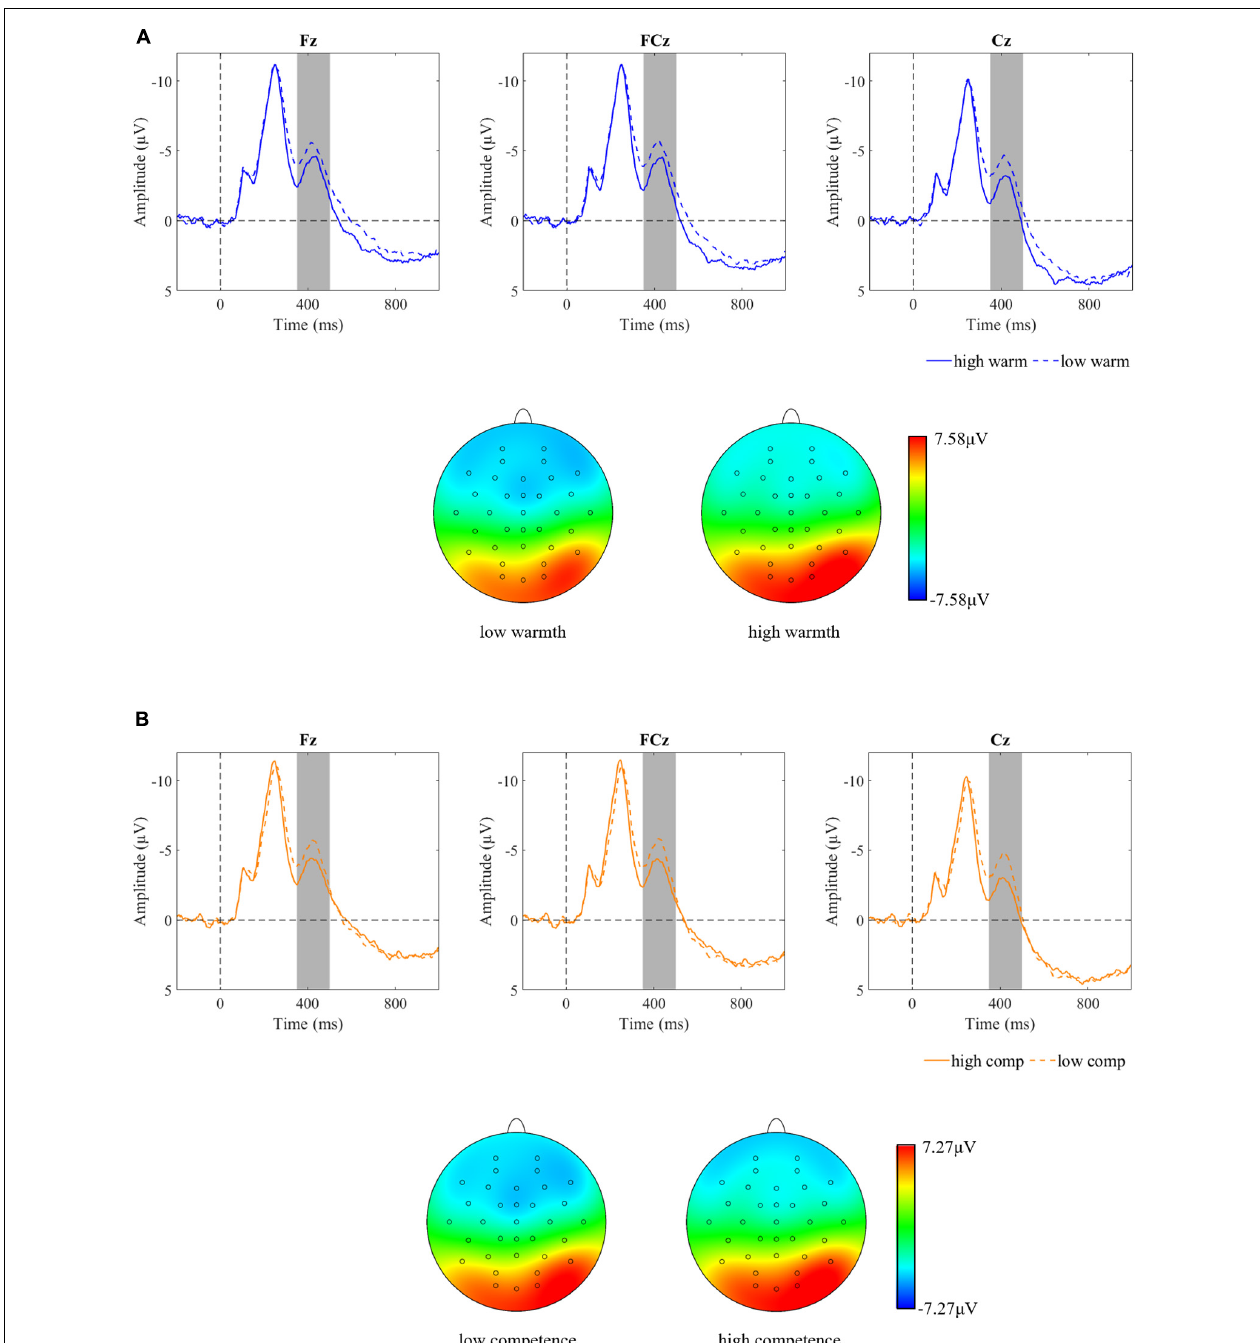
FIGURE 3 | Brainwaves and scalp topographies of the N400 activity for two dimensions. (A) Warmth dimension. (B) Competence dimension.